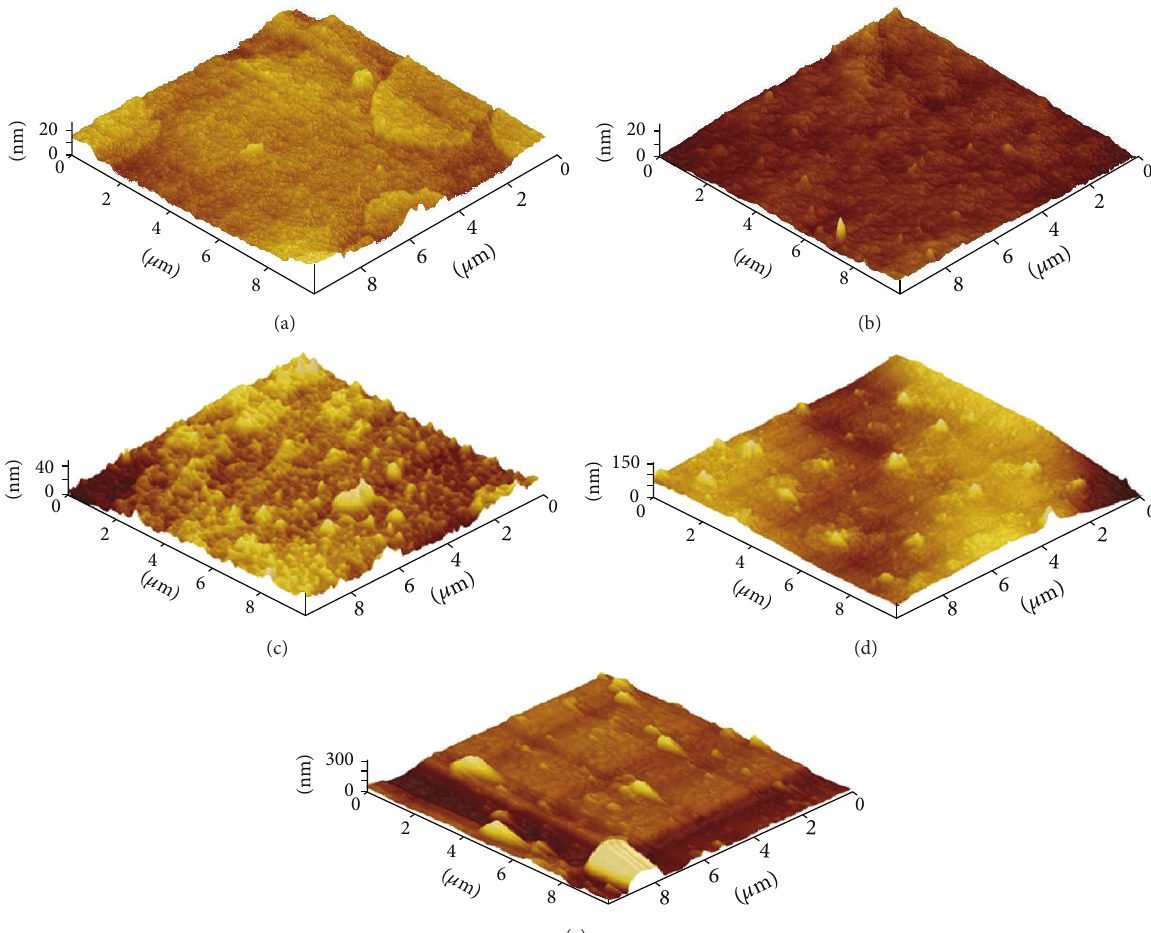
Figure5:AFM(3D)imagesof(a)chitosanfilm,(b)chitosan-spinachblendfilm(95: 5),(c)chitosan-spinachblendfilm(90: 10),(d)chitosan- spinach blend film (85: 15), and (e) chitosan-spinach blend film (80: 20). Conflict of